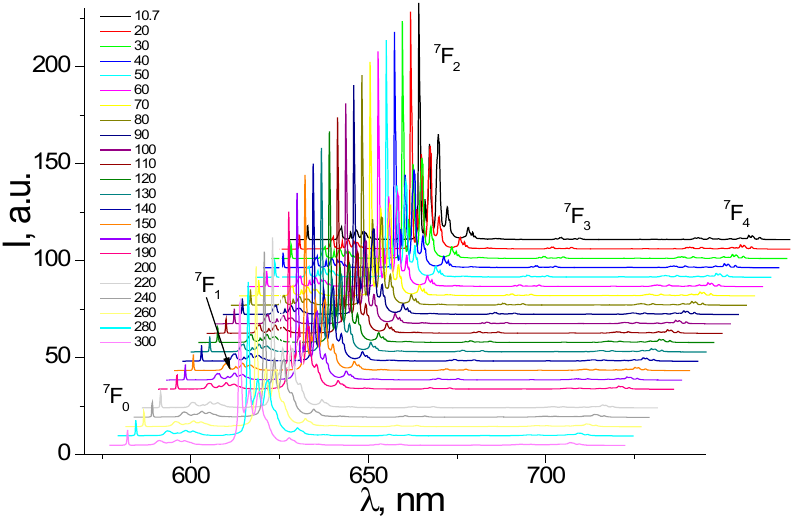
0 → 7 F 2 transition